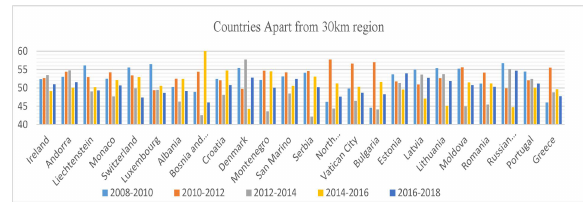
Fig. 4. From 2008 to 2018, the mean CEI values of countries outside the buffer of the CER-Express (European section) were calculated every two years, with the X-axis corresponding to the countries and the Y-axis corresponding to the mean CEI values.